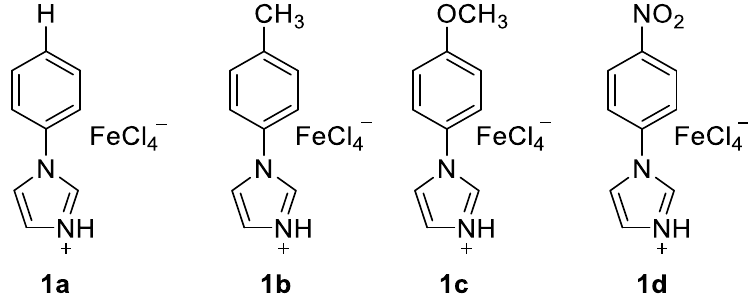
Figure 1. Tunable aryl imidazolium recyclable ionic liquid 1a – 1d with dual activity .